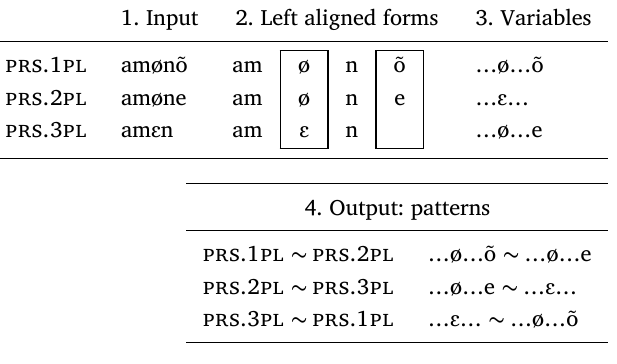
Plural present forms for the verb amener ‘bring’: Global pattern extraction